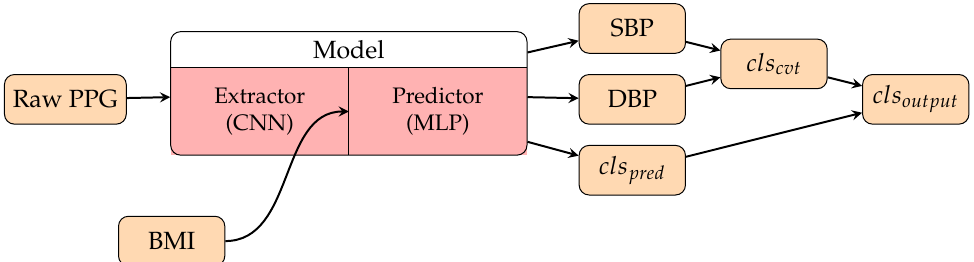
Figure 13. The structure of the algorithm in [138]. The PPG signals are directly put into the CNN part of the model for feature extraction. The model uses the MLP part with the aid of the BMI of the corresponding subjects to predict SBP, DBP, and the hypertension classes. Here, cls pred is the predicted class from the model, cls cvt is the converted class from the regression result, and cls output is the final output class of the